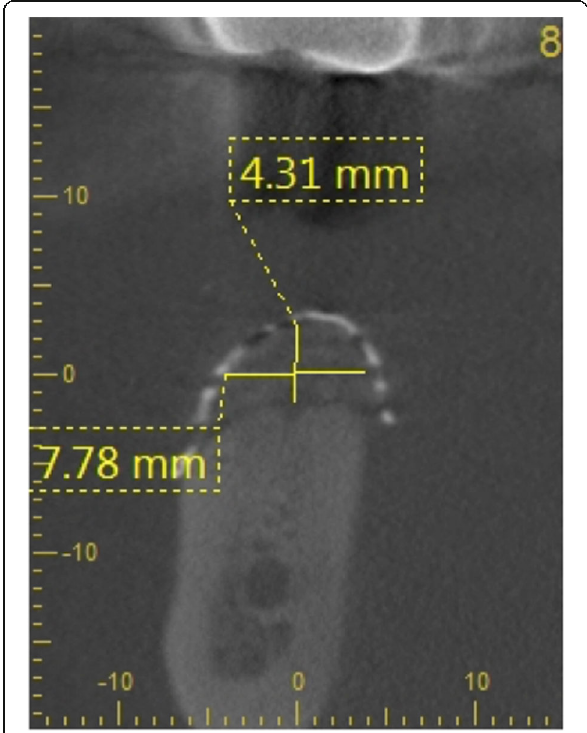
Fig. 9 Representative picture of analysis of vertical and horizontal bone augmentation on CBCT scan